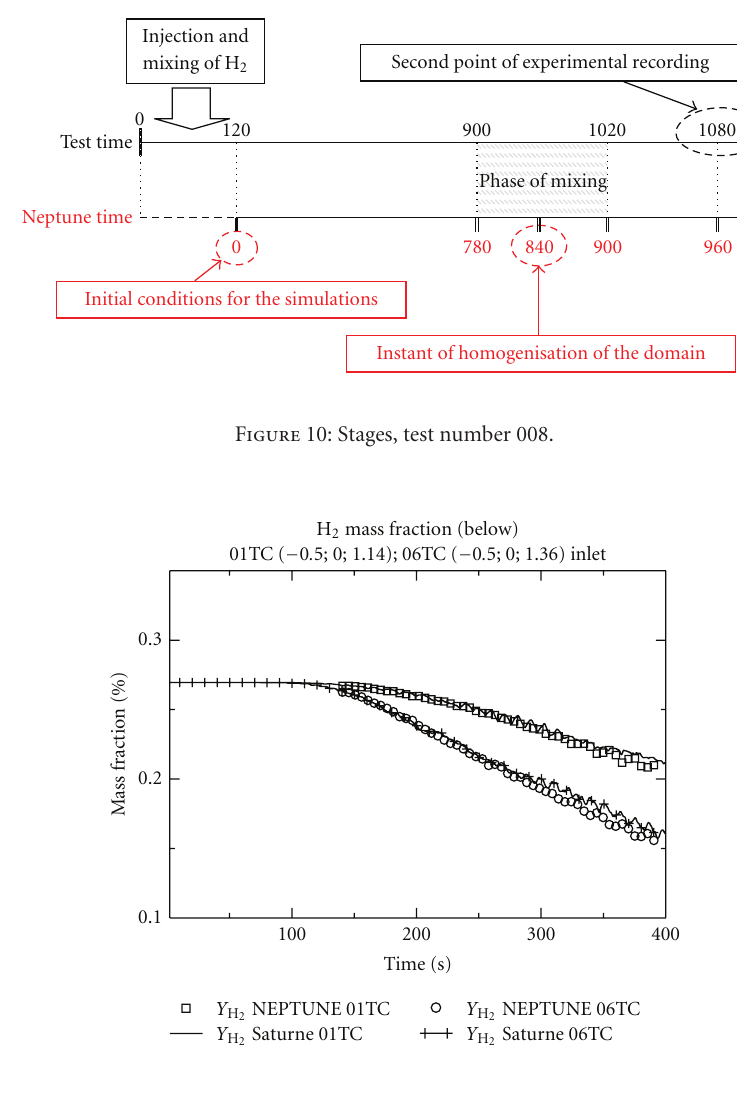
Figure 11: H 2 mass fraction below the